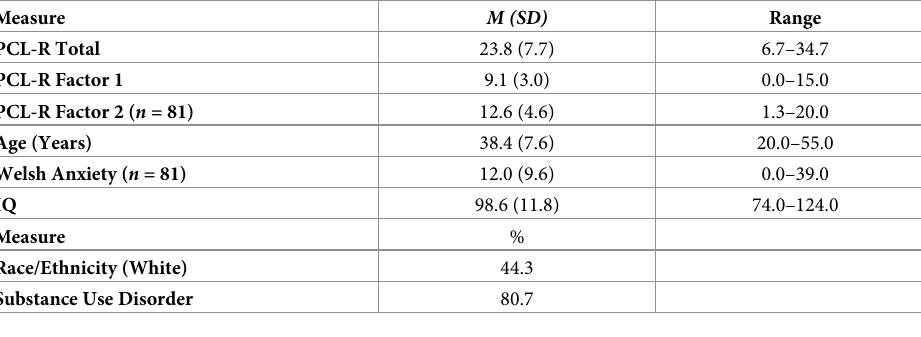
Table 1. Participant characteristics ( N =